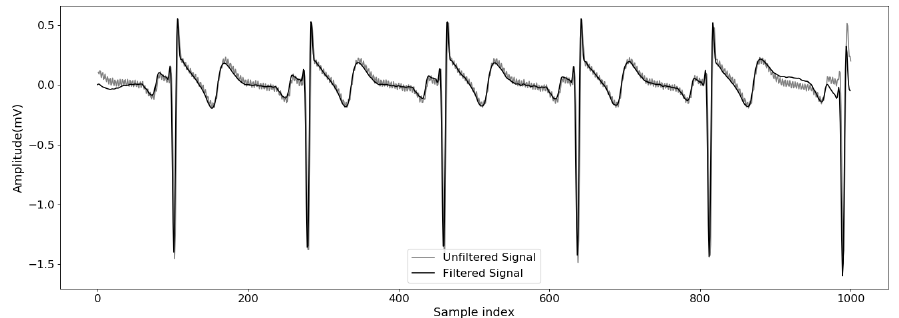
Figure 2. Unfiltered and filtered